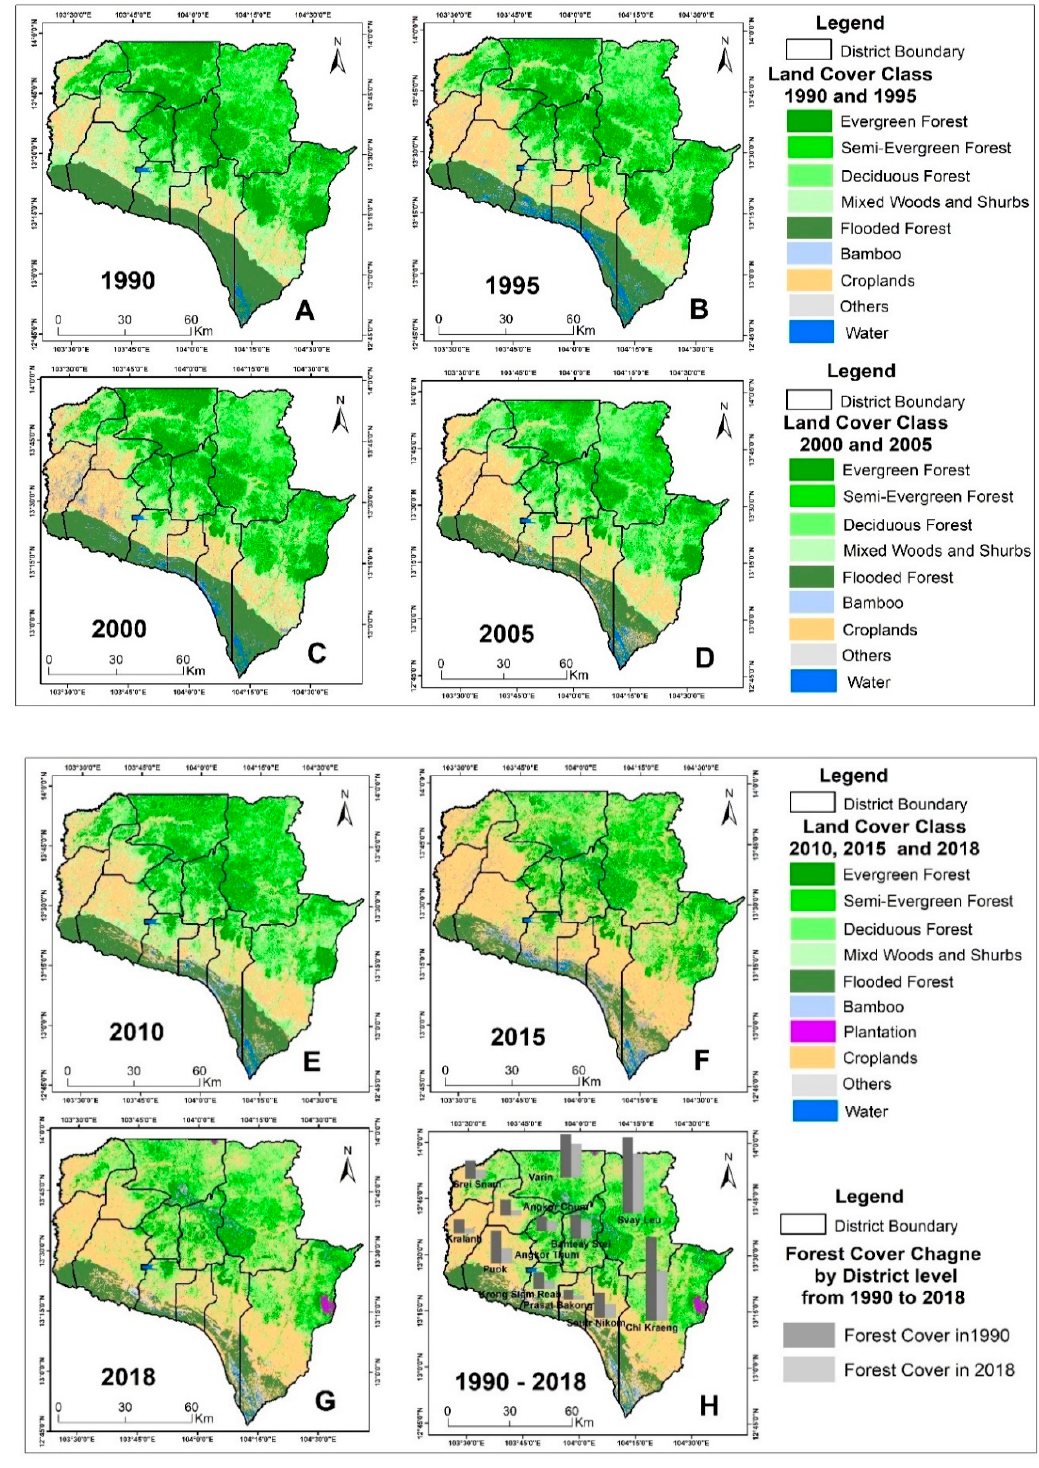
Figure 5. Land cover in Siem Reap province in 1990 ( A ), 1995 ( B ), 2000 ( C ), and 2005 ( D ), 2010 ( E ), 2015 ( F ), and 2018 ( G ), and forest cover change at the district level between 1990 and 2018 ( H ). The graph on the map (Figure 5H) shows the forest cover in 1990 (dark color) and in 2018 (light dark color).